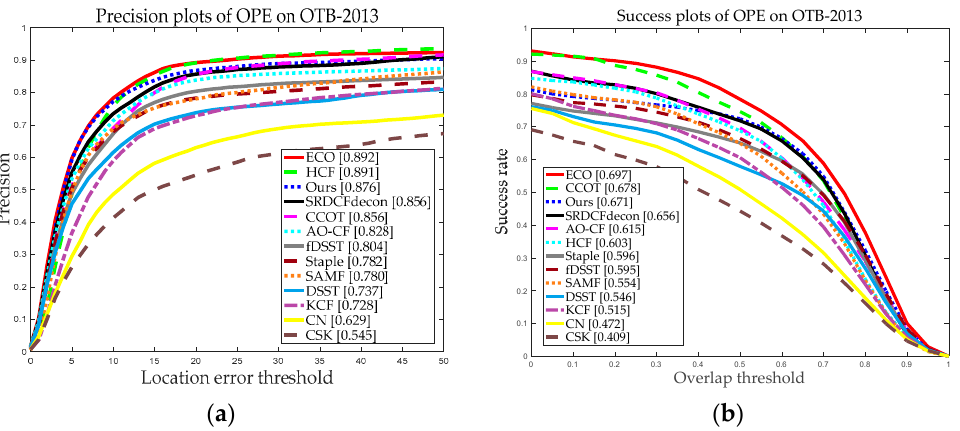
Figure 7. Precision and success plots on the dataset OTB ‐ 2013 using one ‐ pass evaluation (OPE). ( a ) Precision plots of OPE on OTB ‐ 2013; ( b ) Success plots of OPE on OTB ‐ 2013. In the legends, the average distance precisions (DP) rates at a threshold of 20 pix and area under the curve (AUC) scores at a threshold of 0.5 are reported for the precision plots and success plots, respectively.